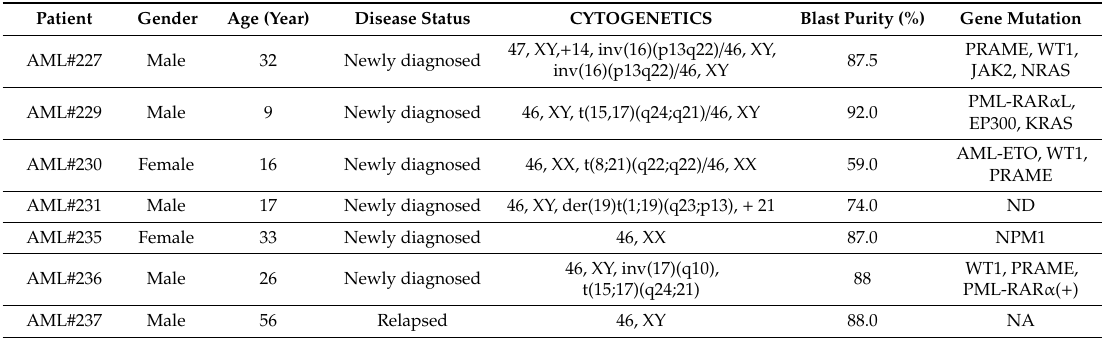
Table 1. Patient characteristics of primary AML patient